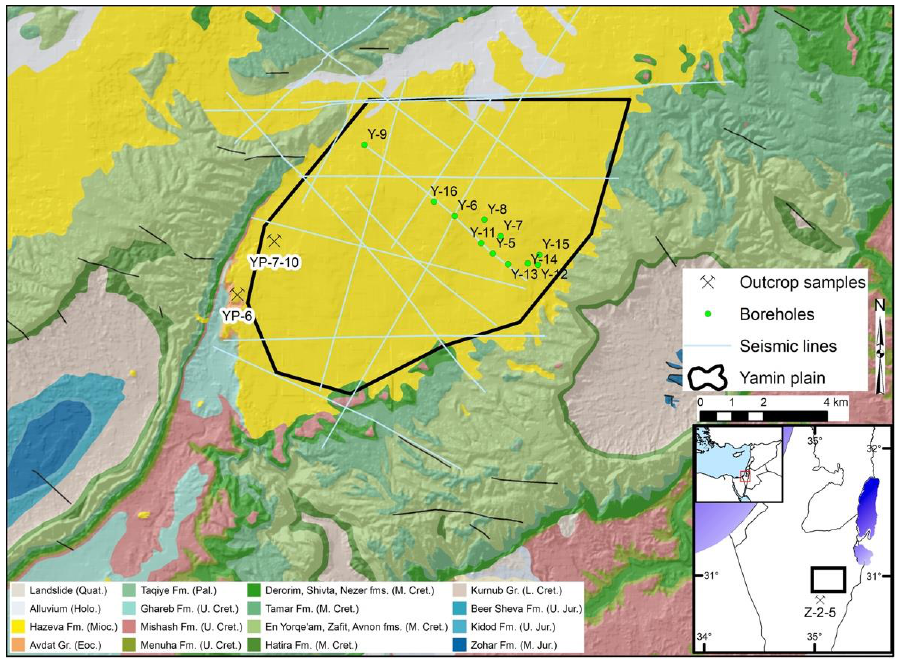
Figure A1. A geologic map of the Yamin Plain, northeastern Negev Desert, Israel. Boreholes (Y-5 through Y-16), seismic lines, and sample locations are indicated. Locations YP-6 and YP-7-10 refer to outcrop locations for samples CK-6 and SS-10, respectively. Sample location Z-2-5 (insert) refers to the location of the Zin Quarry to the south of the Yamin Plain where samples OS-3, and HOP-5 were collected. Geologic units are identified by color (insert).